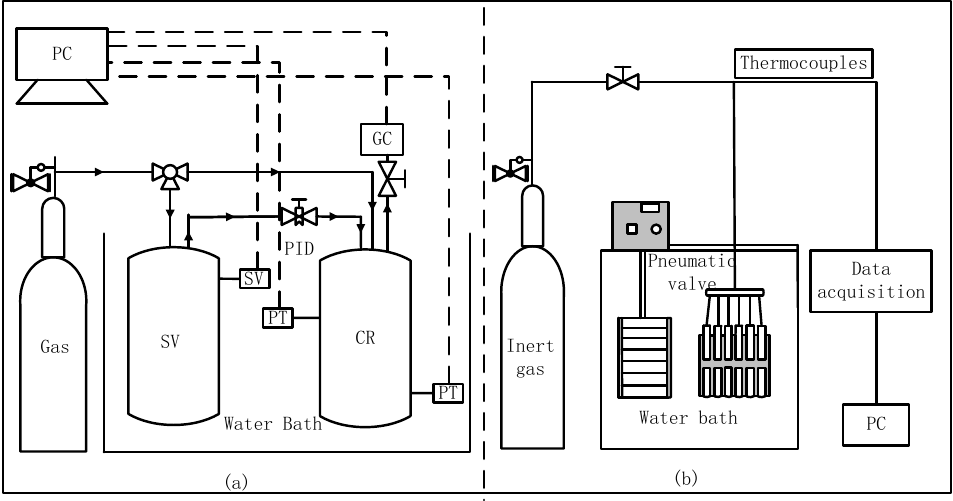
Figure 8. Schematicdiagramofexperimentalequipment. ( a )CO 2 separationapparatus; ( b )Anti-agglomerant Figure 8. Schematic diagram of experimental equipment. ( a ) CO 2 separation apparatus; ( b ) screening device. Anti-agglomerant screening device.